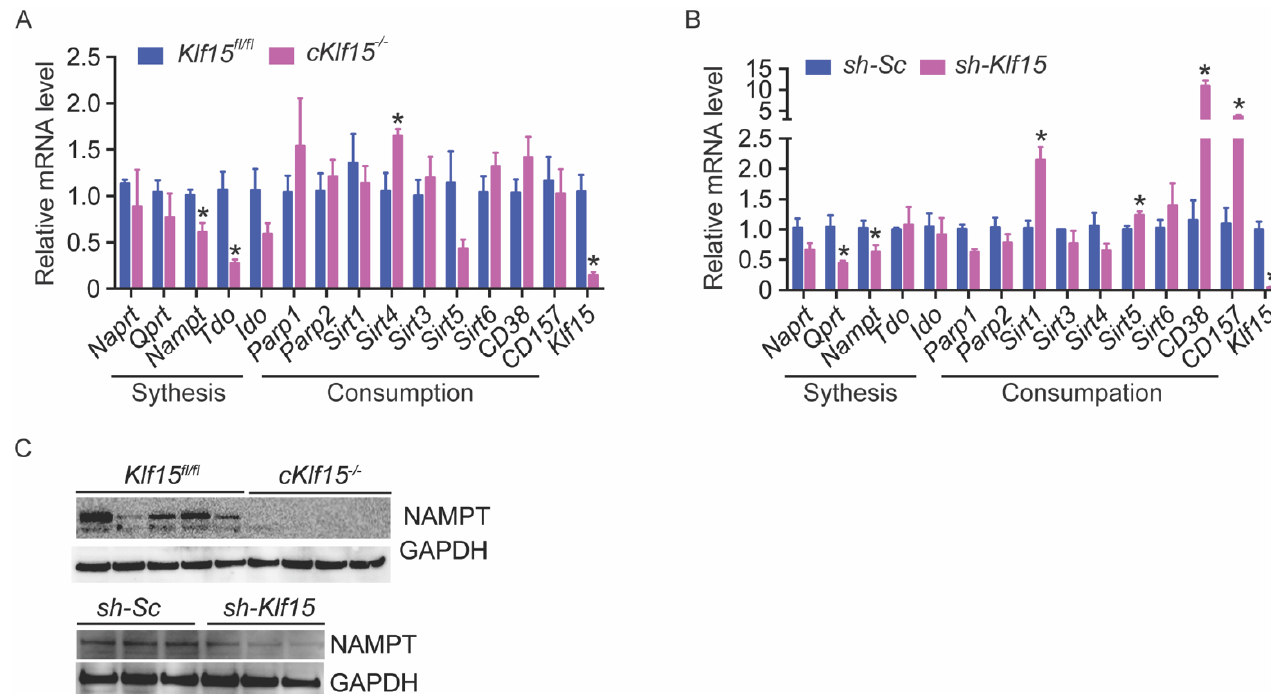
Figure 3. KLF15 deficiency leads to reduced expression of Nampt . ( A , B ) Quantitative RT-PCR results of NAD + synthetic and consuming enzymes in both the cKlf15 KO mice hearts ( A ) and the acute KLF15-deficient NRVM model ( B ) ( n = 3–4, *: p < 0.05 vs. littermate controls or sh-Sc , two-tailed Student’s t -test). Holm–Sidak method was used to correct for multiple t-tests, with alpha set as 0.05. Data are presented as mean ± SEM. ( C ) NAMPT protein expression in cKlf15 KO mice and littermate control hearts (top, n = 4–5) and in NRVM with shRNA knockdown of scrambled RNA ( sh-Sc ) or Klf15 ( sh-Klf15 ) (bottom, n = 3). GAPDH was used as loading control.